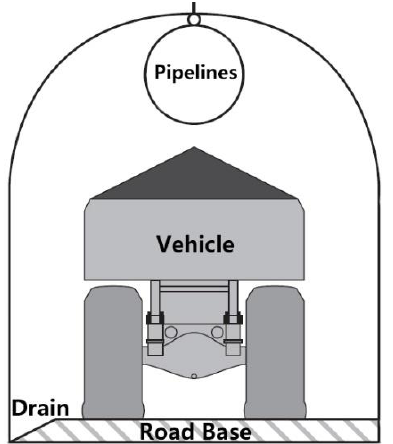
Figure 4. A typical design profile of a drift.